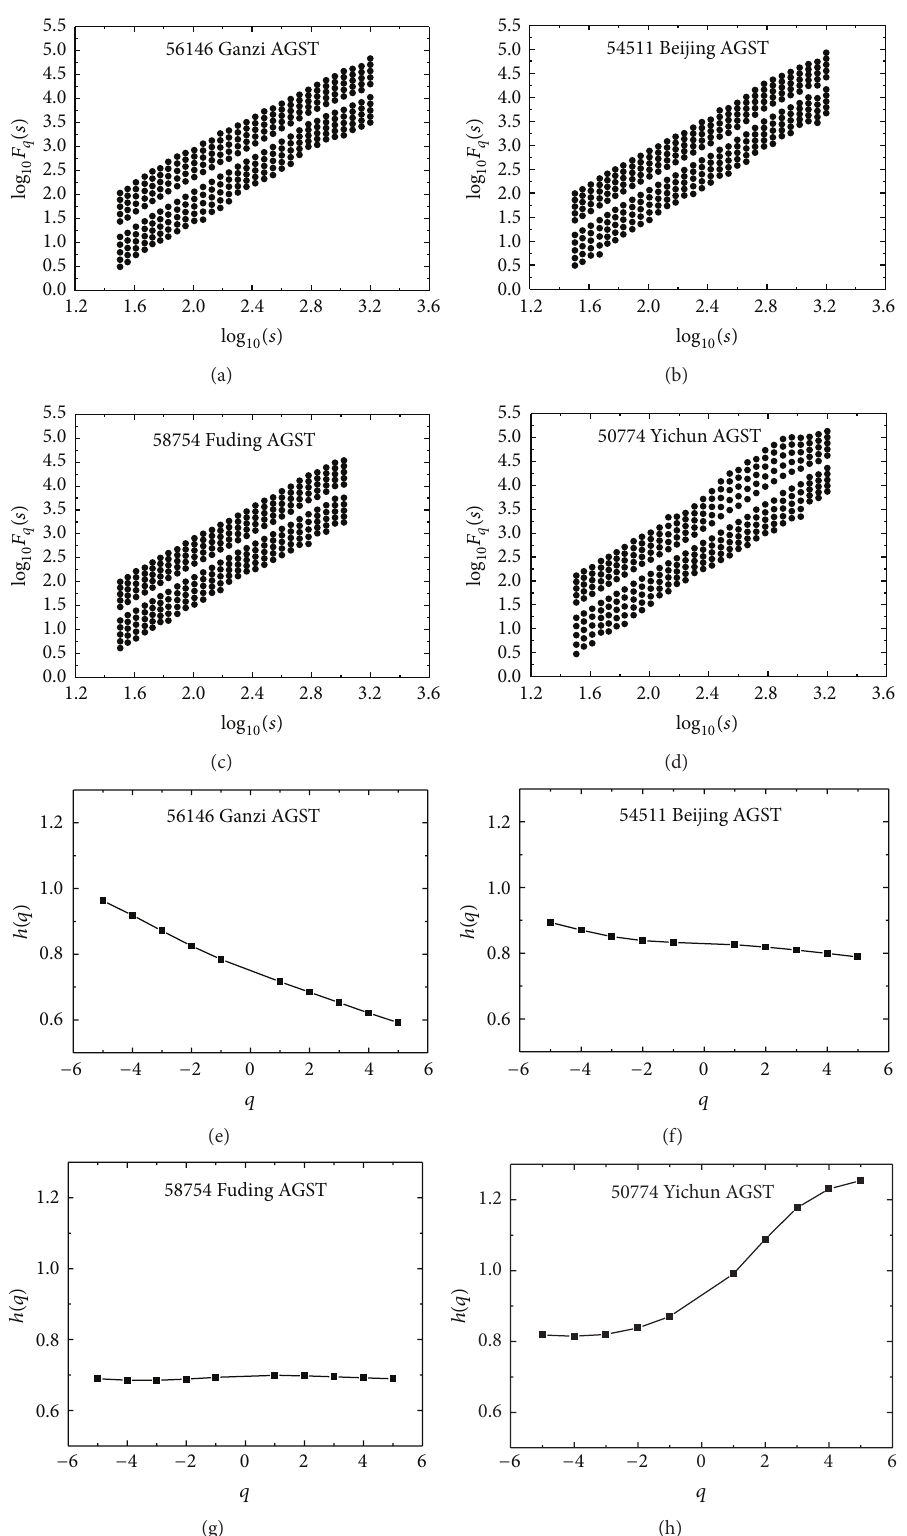
Figure 3: (a) Double log plots of the MF-DFA4 curves of the AGST records for the station Ganzi. From the top to the bottom, curves correspond to different 𝑞 (from 𝑞 = −5 to 𝑞 = 5 ). (b), (c), and (d) The analog to (a) but for Beijing, Fuding, and Yichun. (e) ℎ(𝑞) versus 𝑞 plots for Ganzi. Solid squares: obtained from MF-DFA4 results in (a). (f), (g), and (h) The analog to (e) but for Beijing, Fuding, and